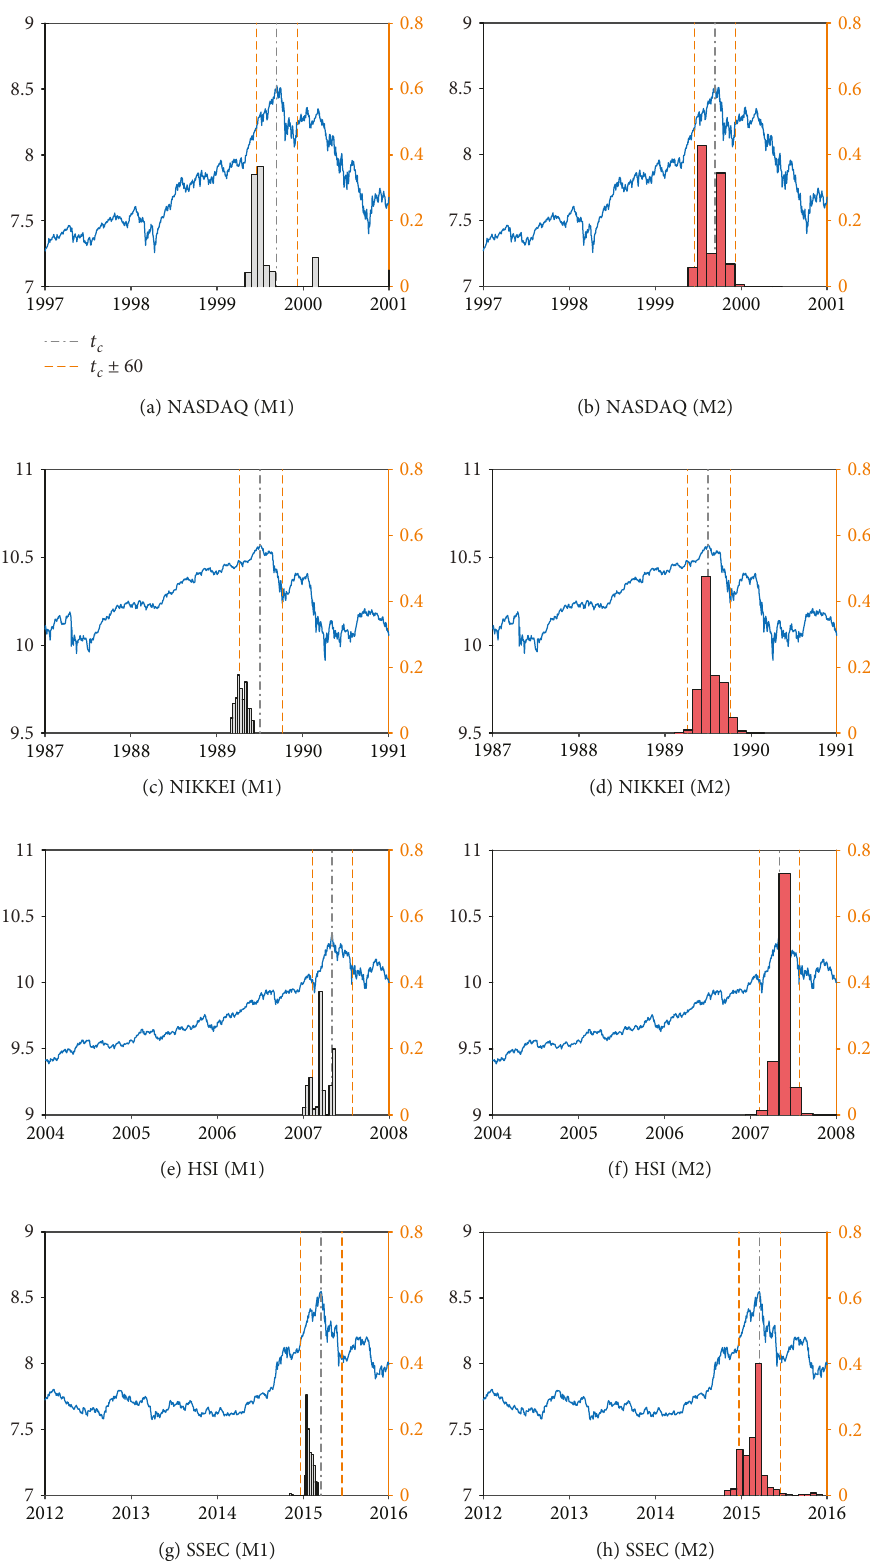
Figure 4: Logarithm of the stock prices and corresponding